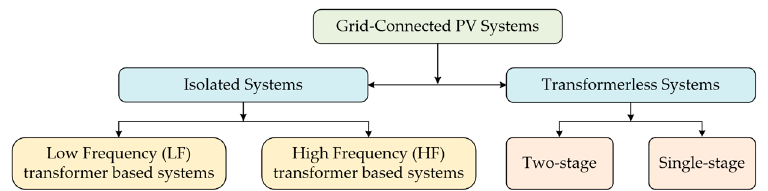
Figure 3. Classification of grid-connected PV systems.